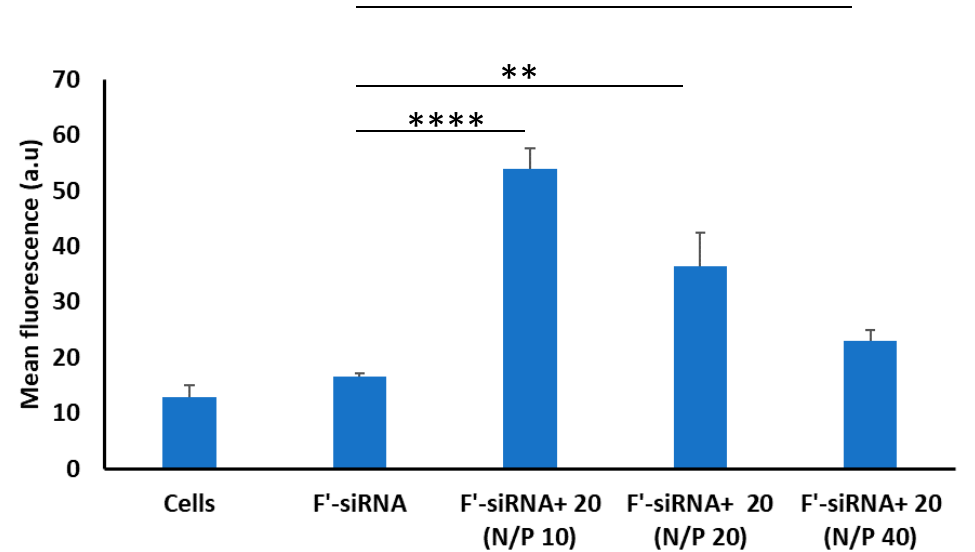
Figure 5. The cellular uptake of fluorescently-labeled siRNA in the presence of tricyclic peptide 20 in MDA-MB-231 cells (if p < 0.01 then **, if p < 0.0001 then